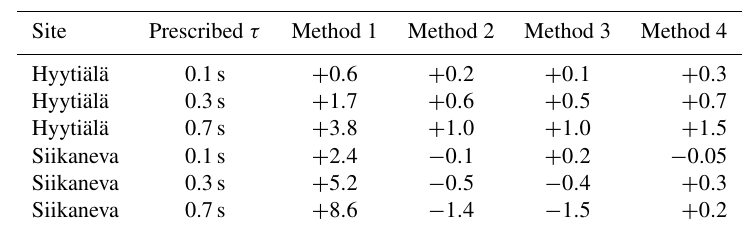
Table 2. Relative difference between the mean sensible heat fluxes obtained with the different correction methods ( ( cor-ref )/ ref · 100%) and the reference (unattenuated sensible heat flux). All values are in per cent (%).